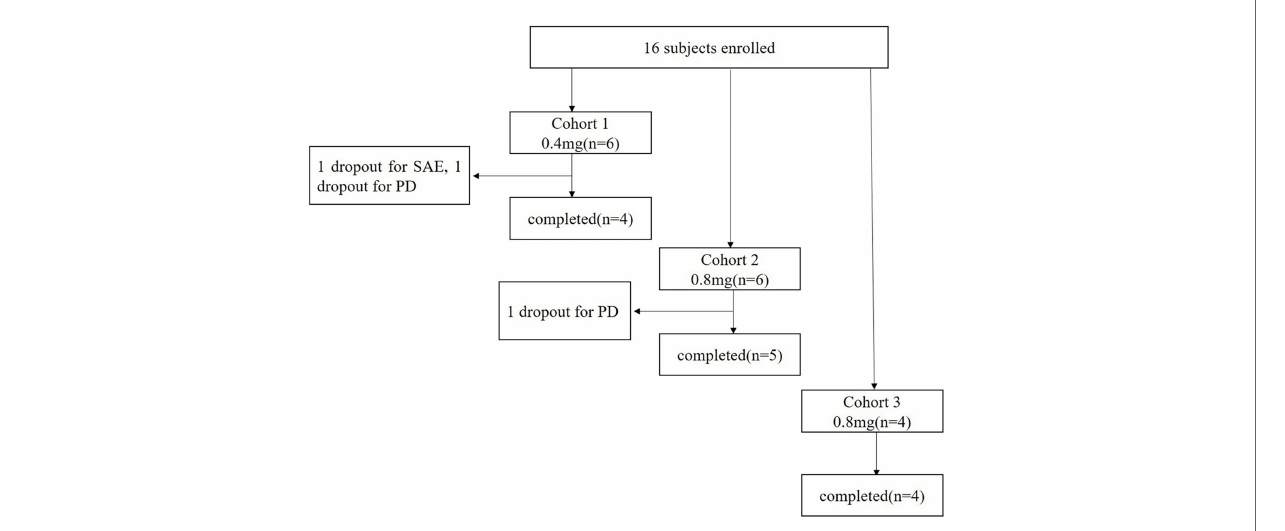
FIGURE 1 | CONSORT Flow